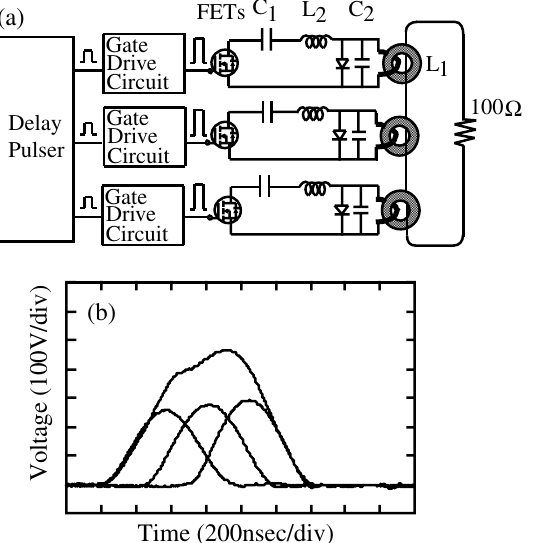
FIG. 15. (a) Schematic diagram of module circuits and (b) wave form using three module circuits (measurement)